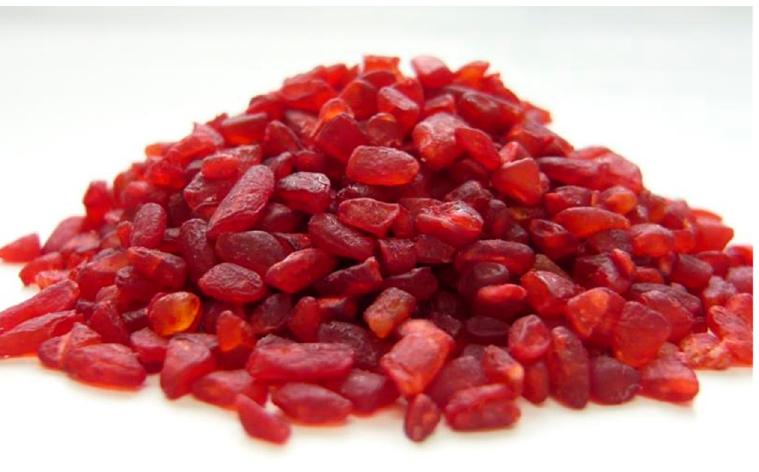
Figure 1. Appearance of red yeast rice.